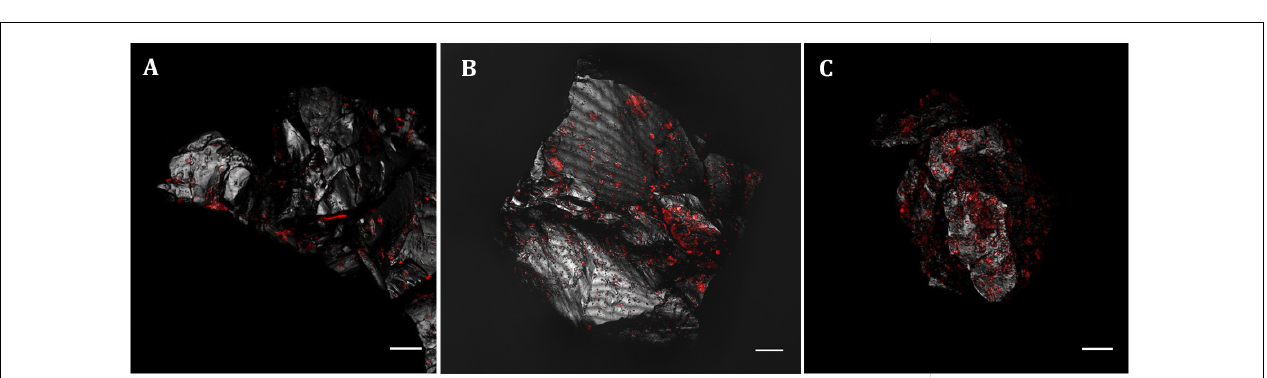
FIGURE 1 | Acidovorax genus in the IPB subsurface analyzed by CARD-FISH. (A) Acidovorax distribution along BH10 column. Black and gray squares indicate presence or absence of microorganisms at a determined depth respectively in membrane filters (M) and rocks (R). (B,C) Acidovorax sp. at 206.6 mbs. In green, Syto9 stain. In red, CARD-FISH signal. In gray, reflection. Scale bars, 5 µ m.